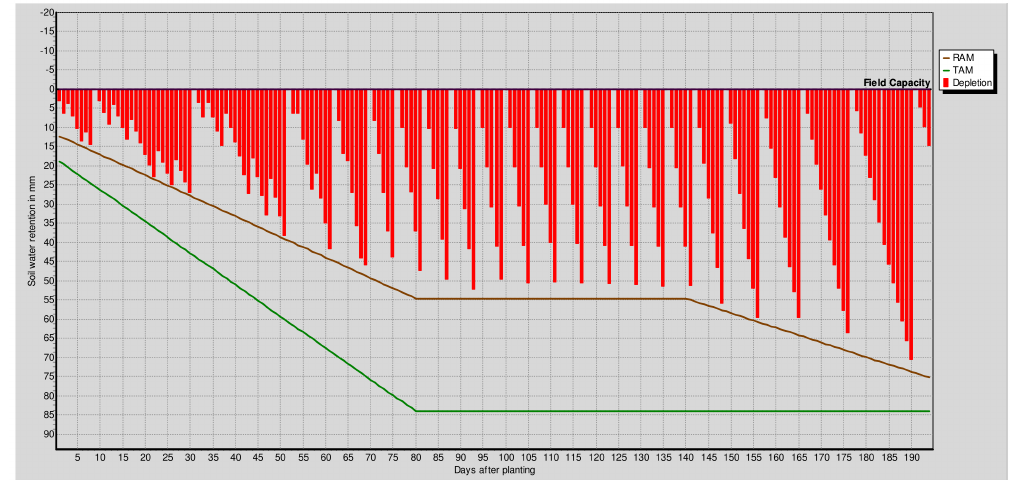
Figure 15. Irrigation schedule for sorghum at site 5 ( x -axis shows days after planting and y -axis shows soil water retention in mm). TAM = total available moisture; RAM = readily available